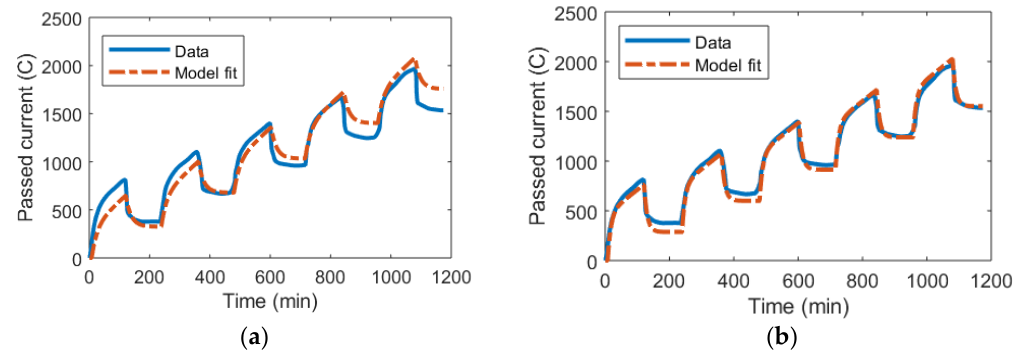
Figure 7. The total accumulated current passed through a CDI device over multiple cycles of adsorption at 1.1 V and desorption with no applied voltage. Data from [70]. Note that the difference between the adsorbed and released charge constitutes the leakage. ( a ) The circuit model was implemented using classic parameter extraction as derived in the theory section. ( b ) The circuit model was implemented using a nlgreyest system identification method in MATLAB for parameter extraction.